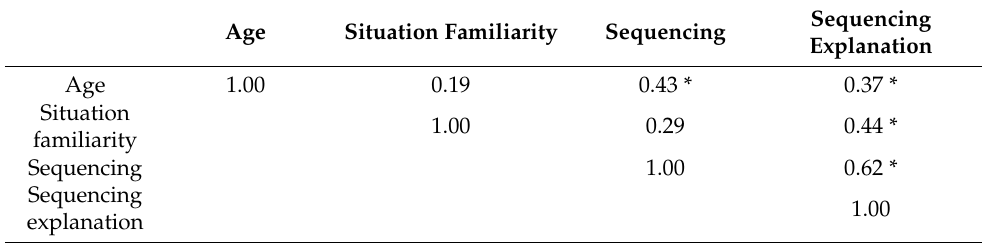
Table 4. Spearman rank correlations between